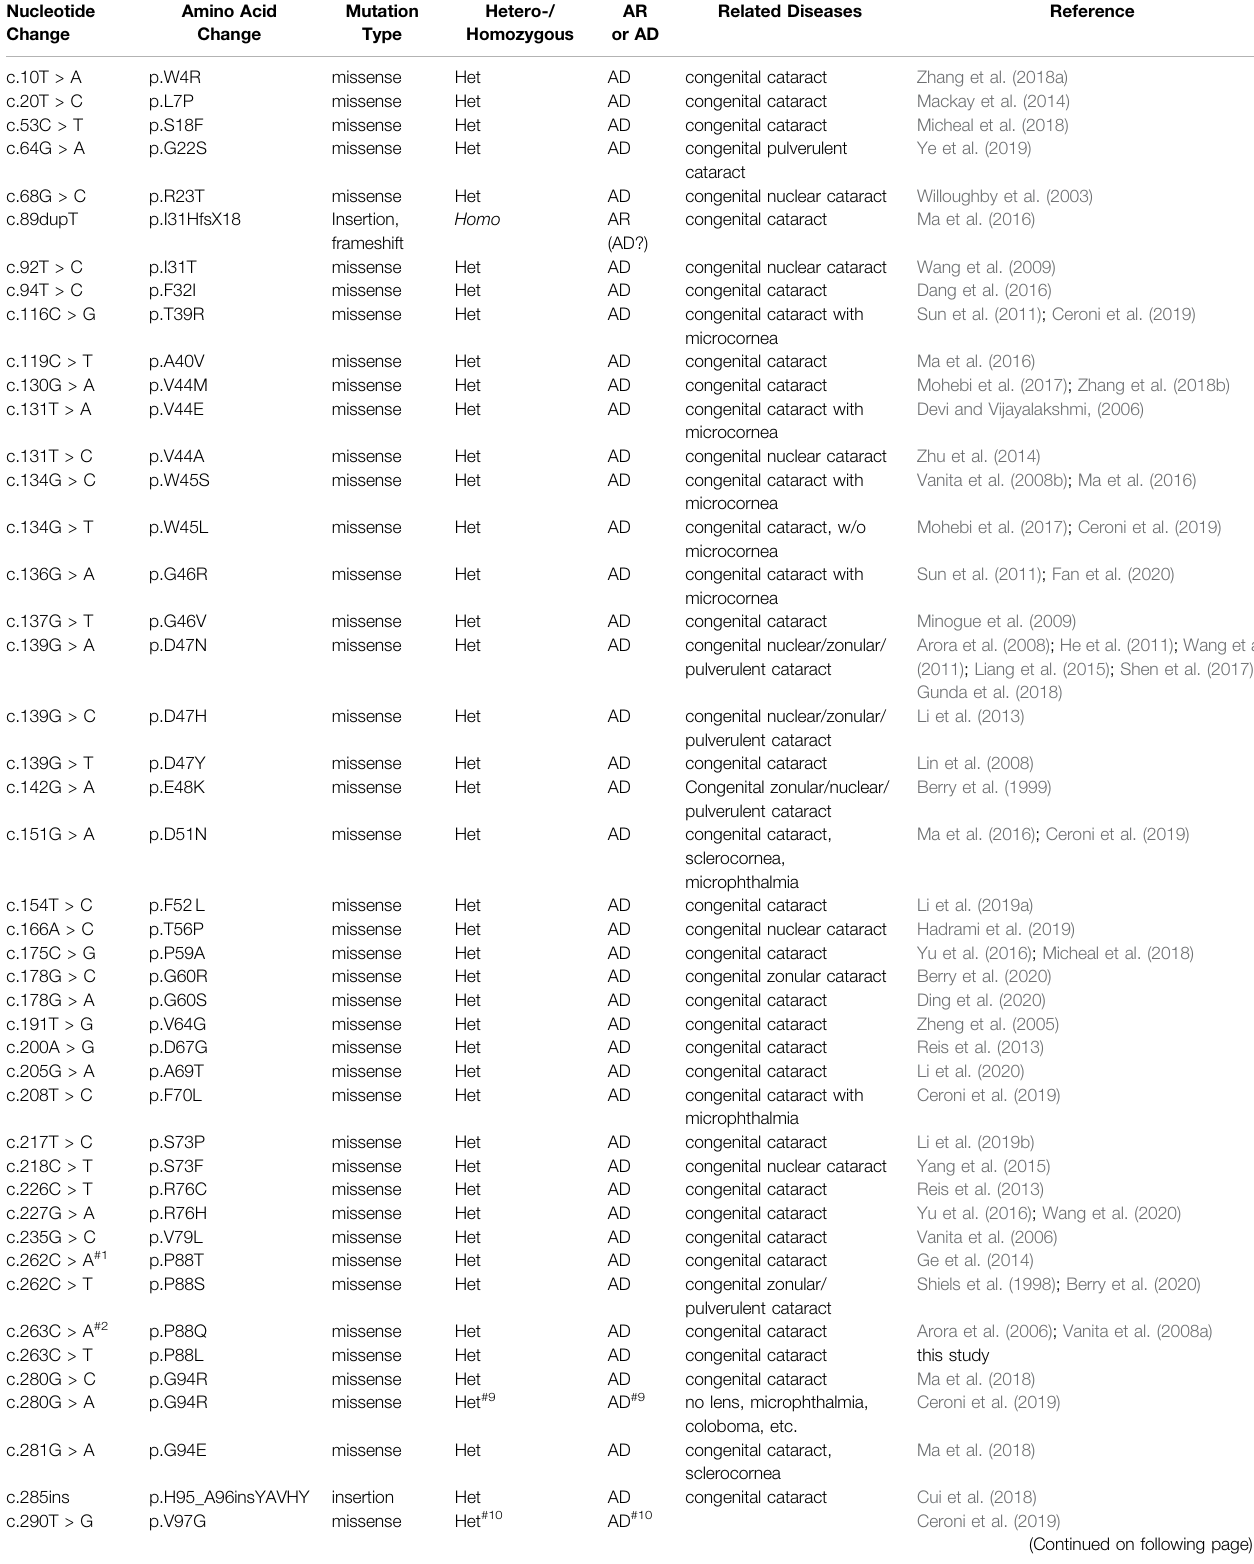
TABLE 1 | Reported human GJA8 mutations and related